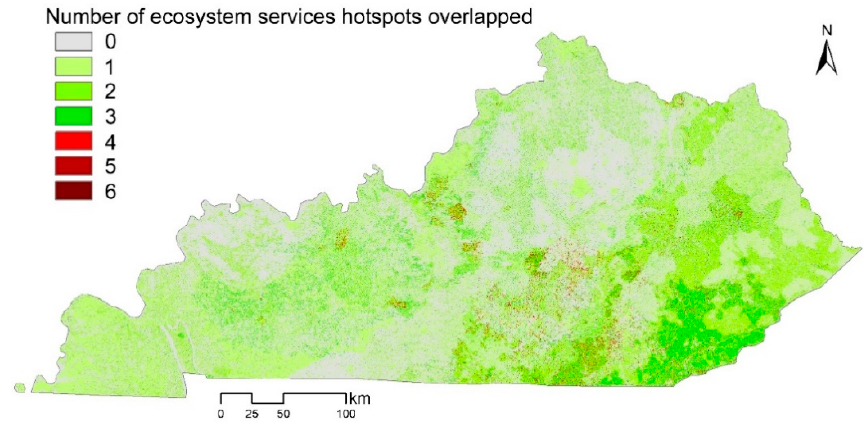
Figure 5. Concurrence of the seven ecosystem services hotspots.